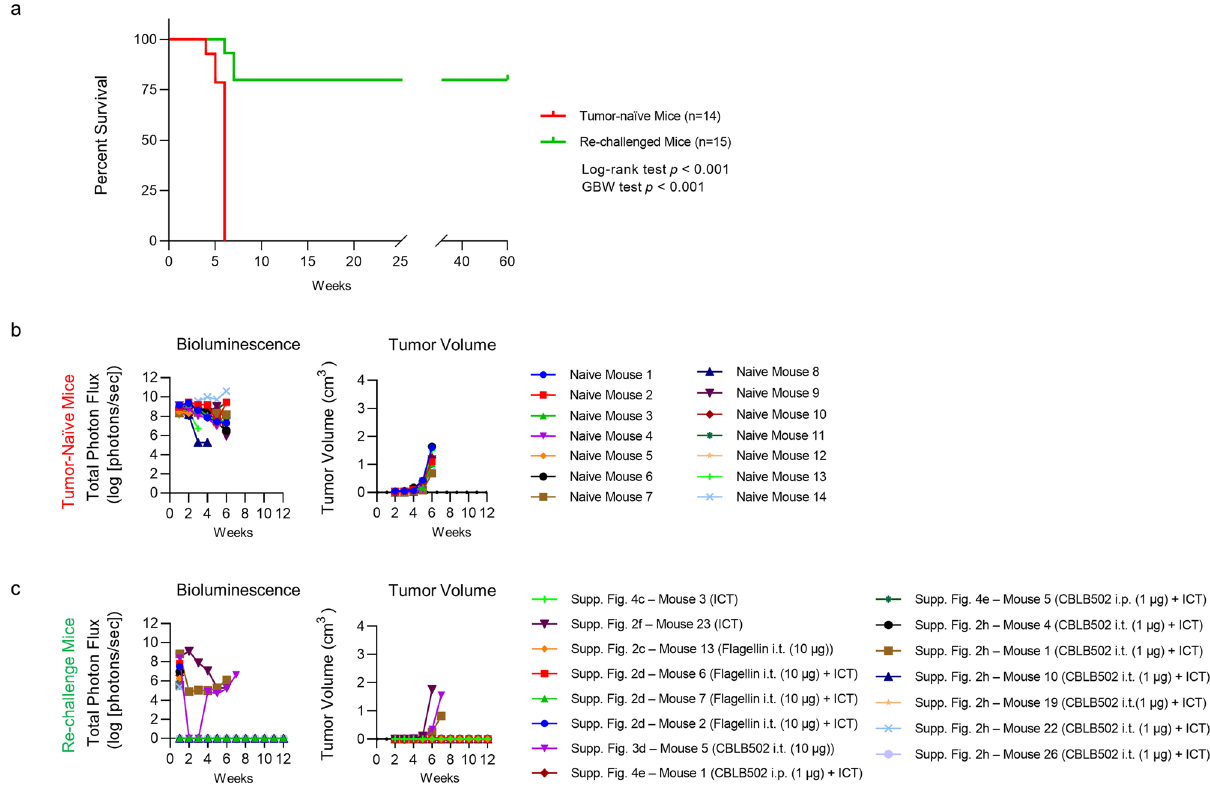
Fig. 3 Immune memory in 4T1 FUGW-FL tumor-bearing mice. a Kaplan – Meier survival analysis of BALB/c mice that survived at least 18 weeks post 4T1 FUGW-FL tumor implantation and showed no sign of tumor, but were re-challenged with orthotopic 4T1 FUGW-FL tumor cells in the contralateral (left) fourth mammary fat pad ( n = 15) and age-matched control tumor-naïve mice ( n = 14). All mice were injected at week 0 with 4T1 FUGW-FL tumor cells and tumors were allowed to grow without therapeutic intervention. Re-challenged mice showed 80% survival rate ( p = 0.0001, Log-rank test; p = 0.0001 Gehan – Breslow – Wilcoxon). b Tumor size of tumor-naïve mice ( n = 14) measured by bioluminescence imaging (total photon fl ux, left panel) and caliper measurements (tumor volume, right panel). All tumor-naïve, tumor challenged-mice died by week 6. c Tumor size of re-challenged mice ( n = 15) measured by bioluminescence imaging (total photon fl ux, left panel) and caliper measurements (tumor volume, right panel). Only three tumor survivor mice died due to tumor burden: Supplementary Fig. 2f-mouse 23 (ICT), Supplementary Fig. 2h-mouse 1 (CBLB502 1 µ g (i.t.) + ICT), and Supplementary Fig. 3d-mouse 5 (CBLB502 10 µ g (i.t.)) and, (Supplementary Table 5). All other tumor survivor mice were tumor-free for at least 60 weeks post orthotopic tumor